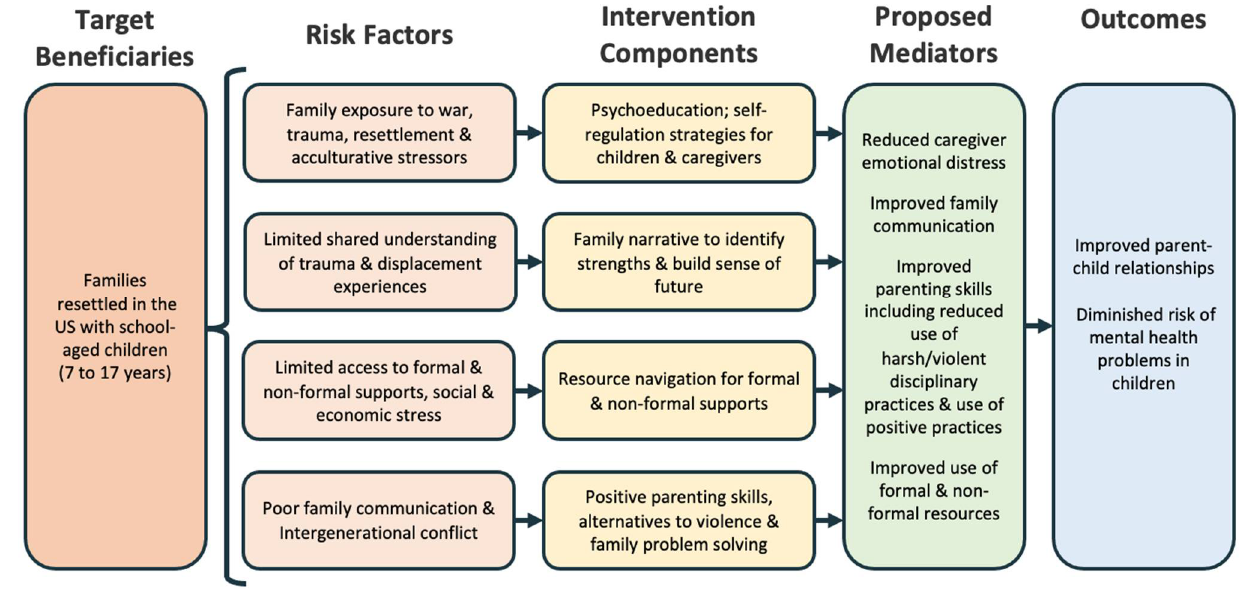
Figure 1. Refined conceptual model of the FSI-R.